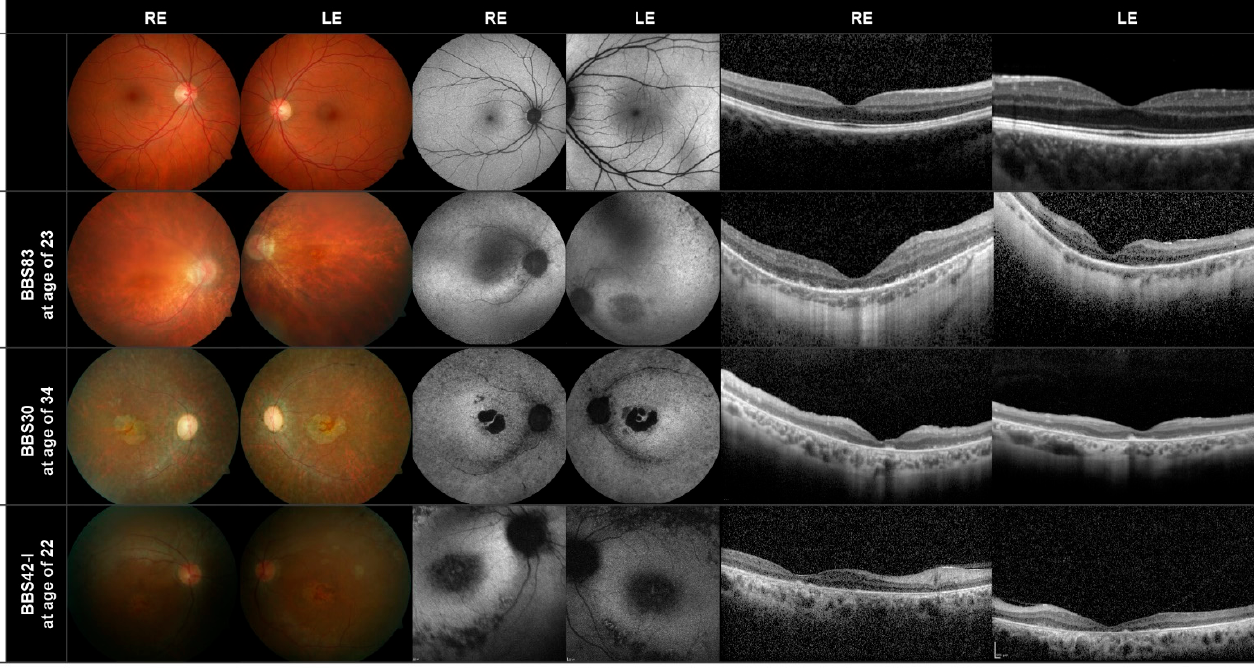
Figure 2. Fundus ( left ), AF ( center ) and OCT ( right ) images of representative patients with disease- causing variants in the BBS1, BBS10, and the BBS9 genes. The images of a normal eye are shown in the first